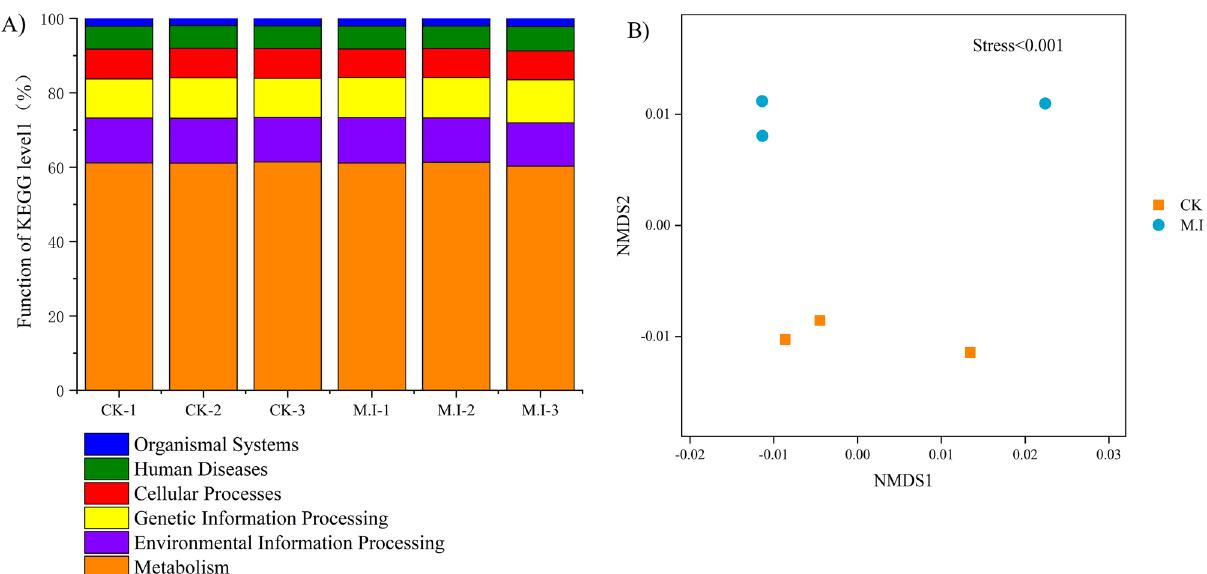
Figure 3. Microbial metabolic function in soil of the pristine forest forests and M. micrantha -invaded forest. ( A ) Relative abundances of soil microbial metabolic function at KEGG level 1. ( B ) The non-metric multidimensional scaling (NMDS) plot of microbial metabolic function at KEGG level 3 in